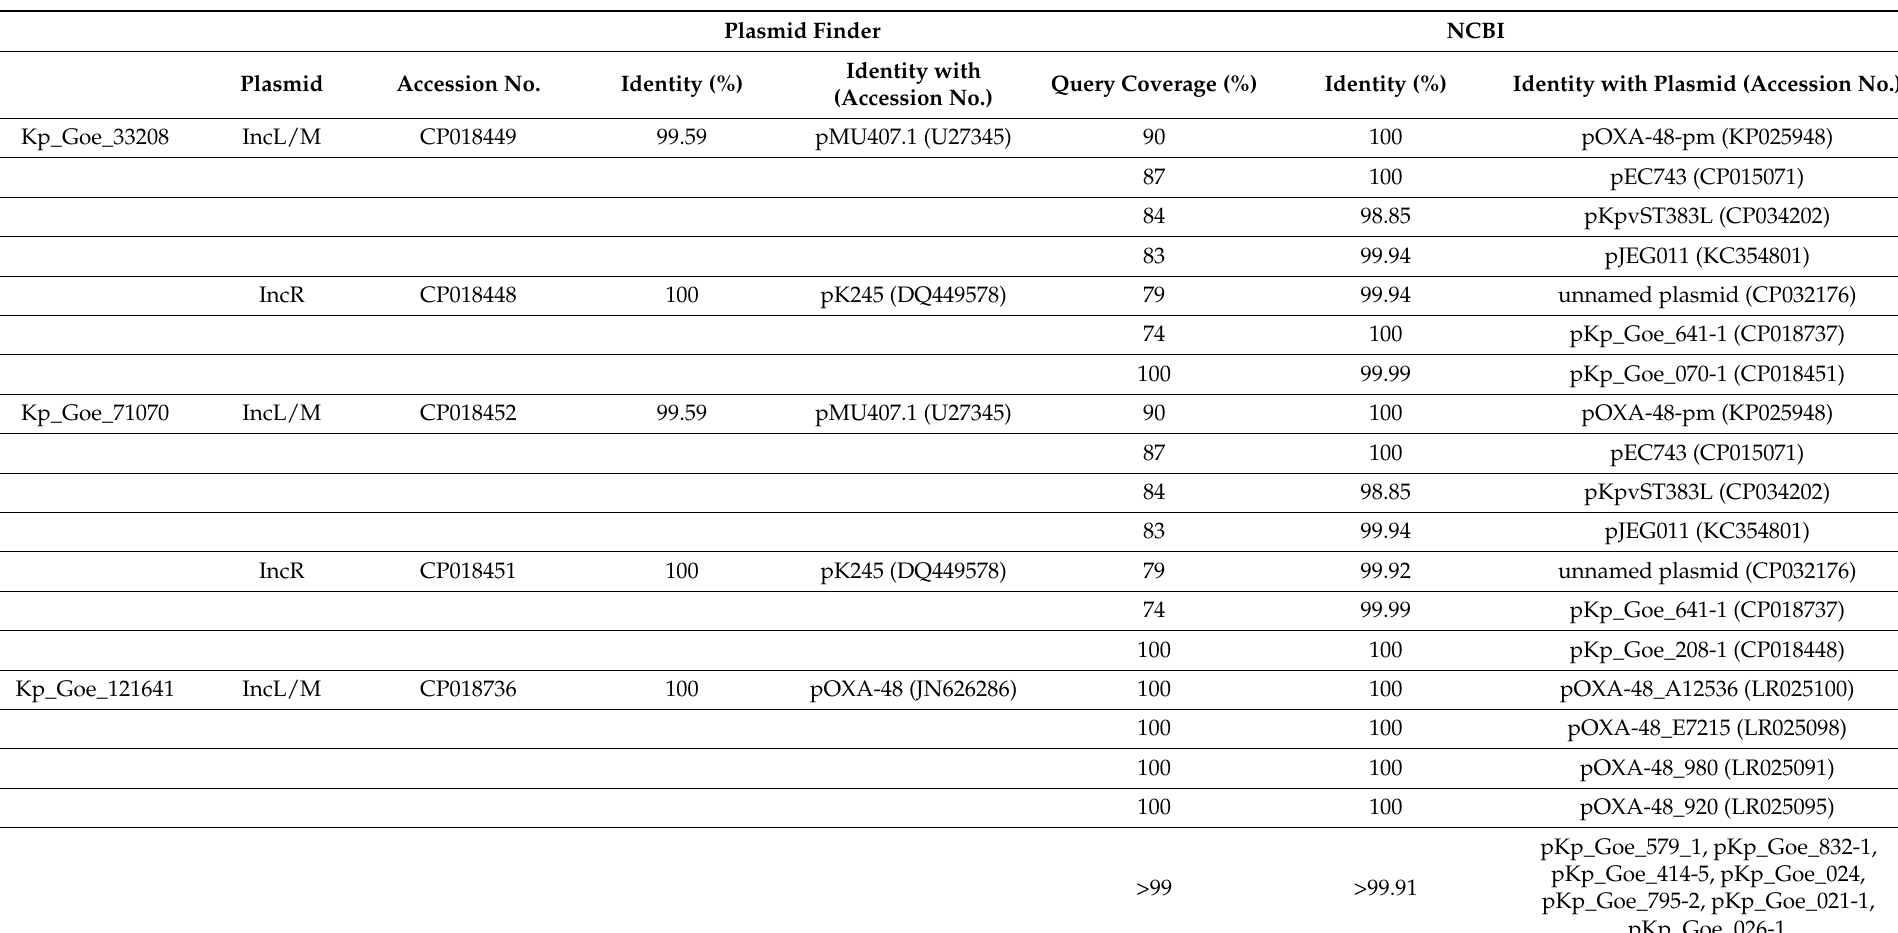
Table A1. GenBank Accession numbers and BLAST results of the plasmids of Klebsiella pneumoniae isolates on the basis of PlasmidFinder-2.0 of Center for Genomic Epidemiology (CGE) and National Center for Biotechnology Information